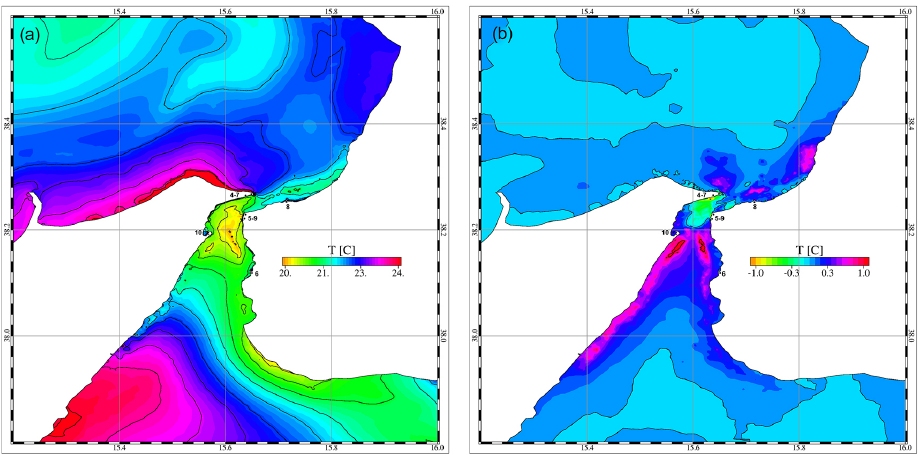
Figure 8. Surface water temperature computed during the summer period: average values from the TTC simulation results (a) and differences with respect to the THO scenarios results (b)